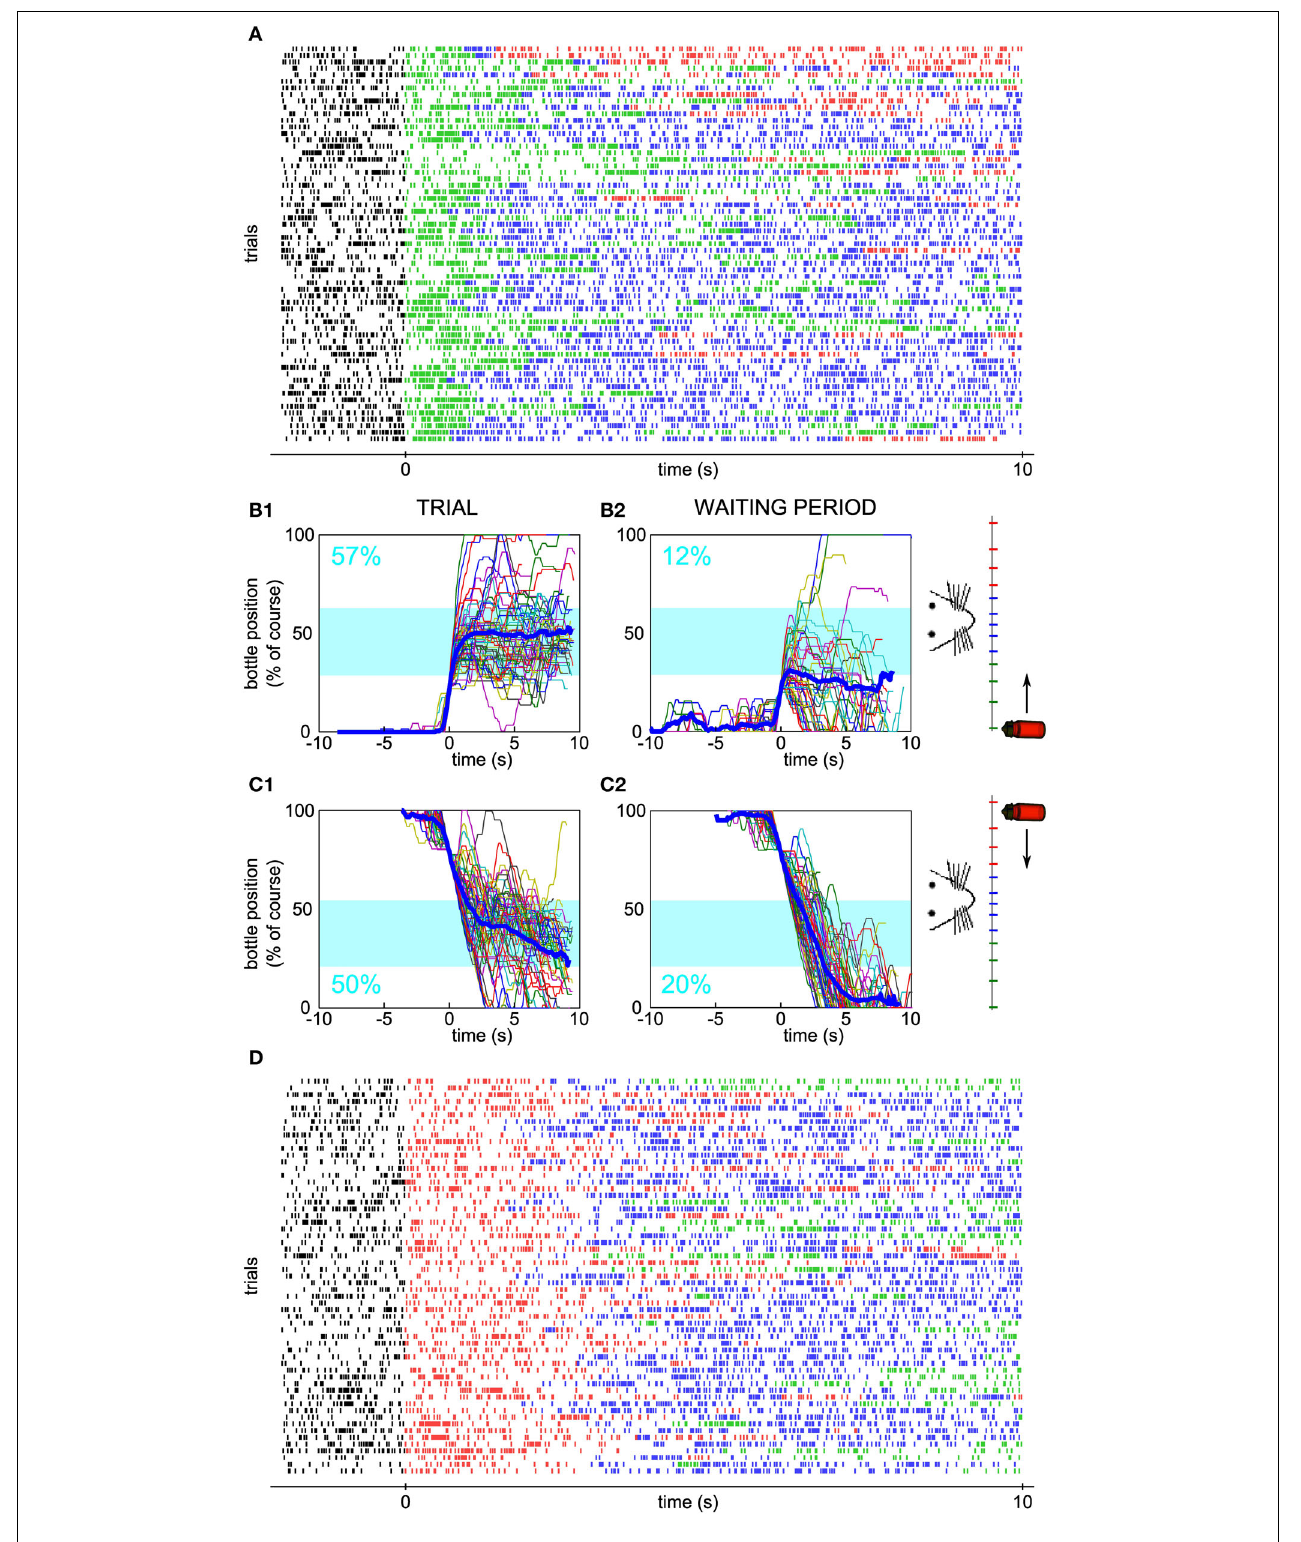
FIGURE 5 | Neuronal bidirectional control for sessions with different starting positions of the bottle. (A) Raster plot of the activity of a conditioned neuron, different than the neuron of Figure 2 , during a session for which the bottle started from the right and an increase in firing rate was